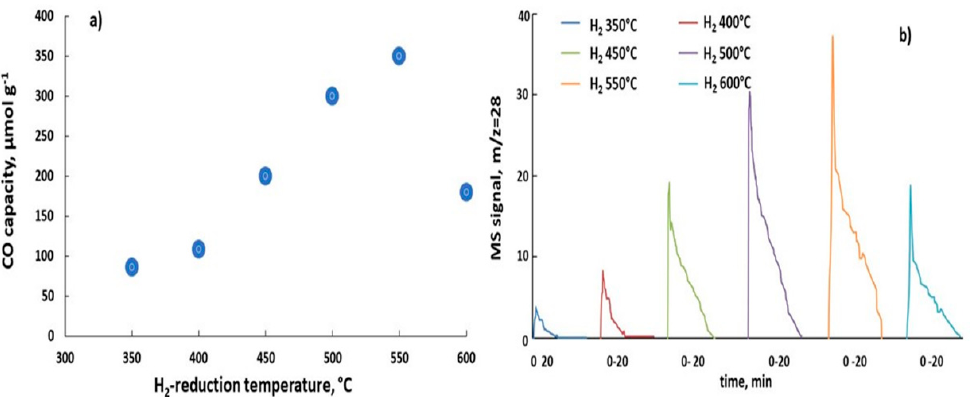
Figure 8. Catalysts 2020 , 10 , x FOR PEER REVIEW